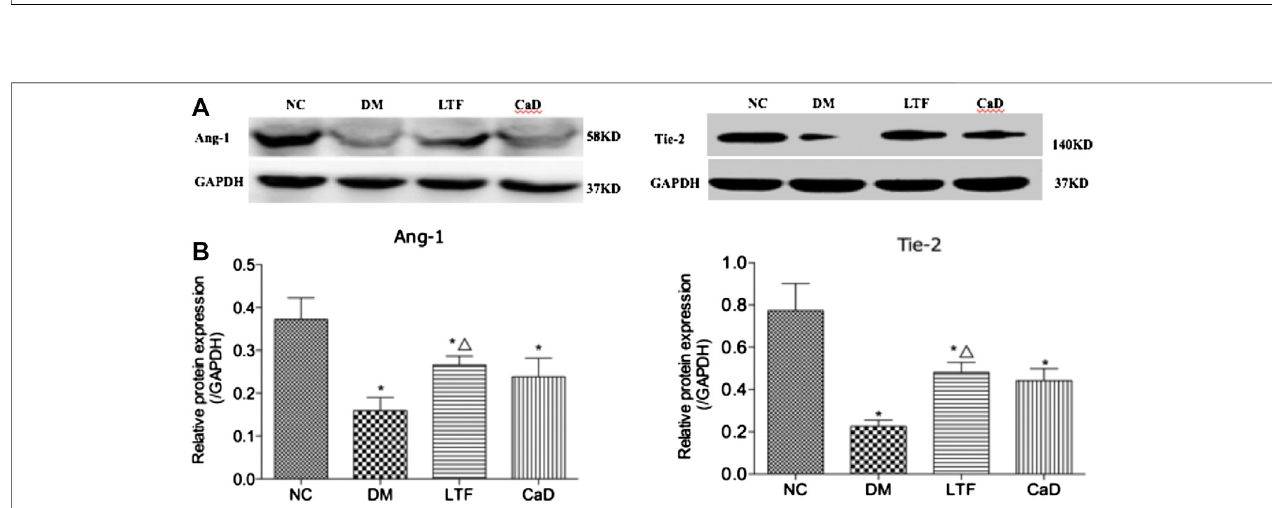
FIGURE8| Effect ofLTFand CaDonthe Ang-1and Tie-2. (A, B) Westernblotand quantitativemeasurementofretinal Ang-1and Tie-2. Dataare mean ± SDfrom six rats per group, and the experiments were repeated independently four times (* p < 0.05: vs. NC group; △ p < 0.05: vs. DM group).